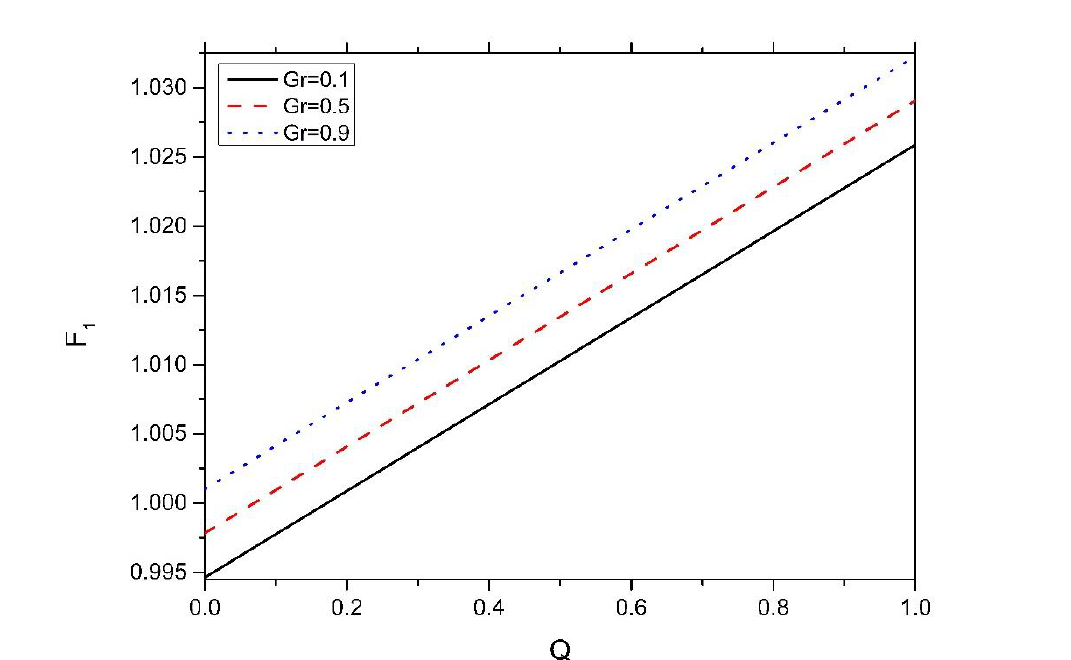
N = 0.3, N = 0.4,  = 0.1,  =0.5, Br = 0.3,  = b t  = 0.01. 1